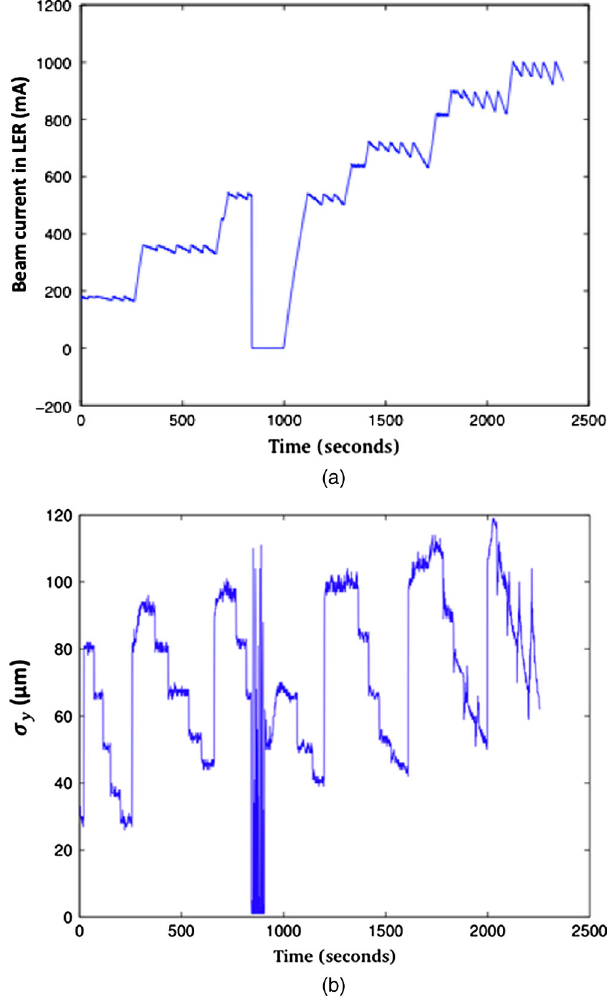
FIG. 16. (a) Beam current and (b) vertical beam size in the LER during the Touschek